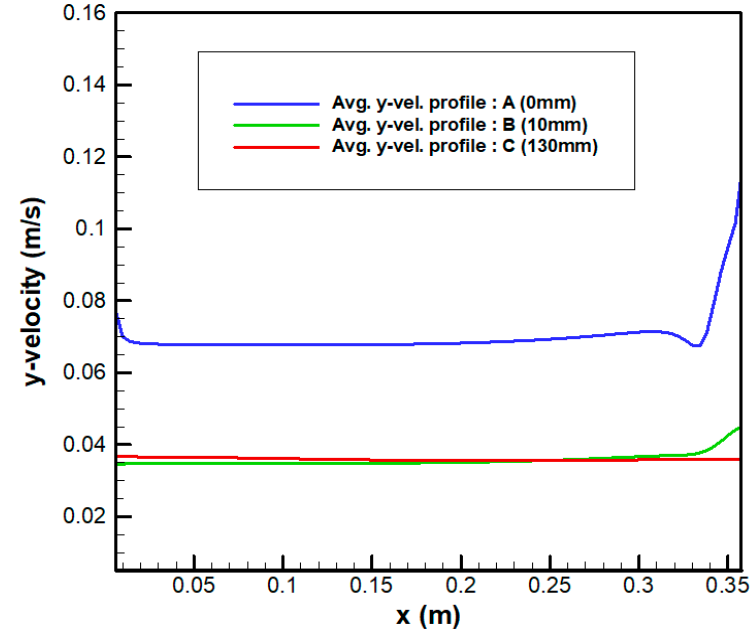
Figure 12. Velocity profile according to electrode position.